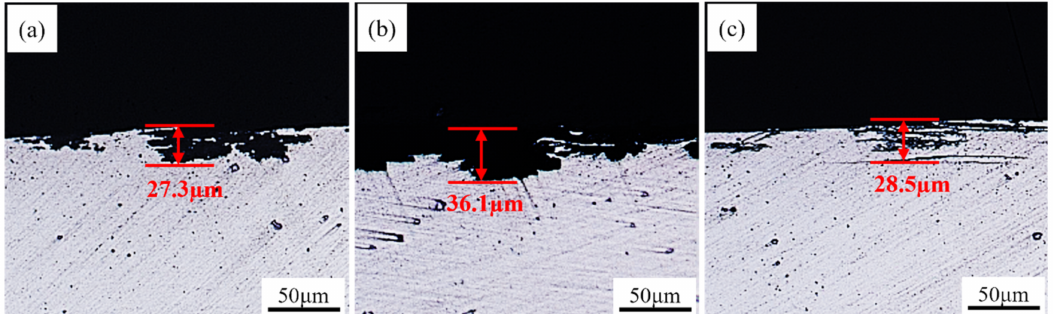
Figure 13. Plots of maximum intergranular corrosion depth of samples at different rolling tempera- tures after aging treatment: S420 ( a ), S450 ( b ), S480 ( c ).